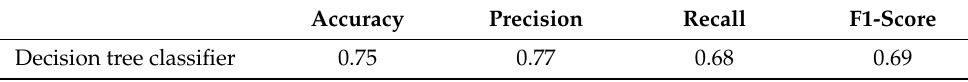
Table 3. Performance metrics of the DT classifier.